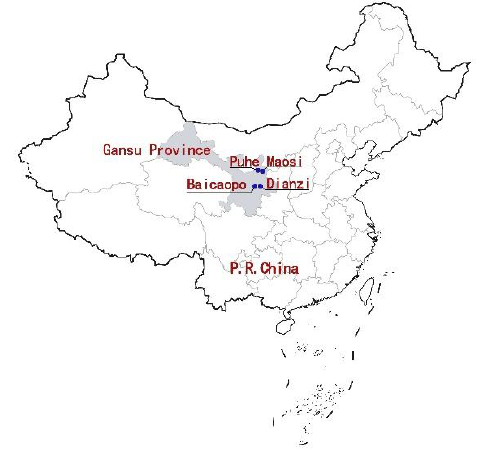
Figure 1. The locations of four villages in Gansu province, China.